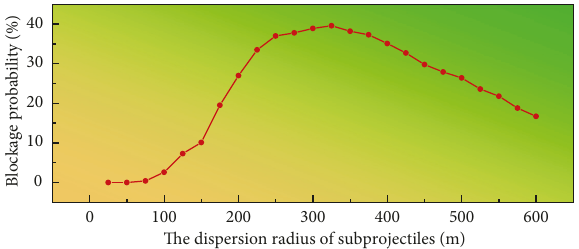
Figure 18: Influence of the dispersion radius of subprojectiles on the blockage